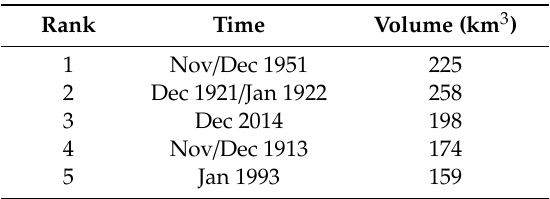
Table 1. Five strongest Major Baltic Inflows since 1897